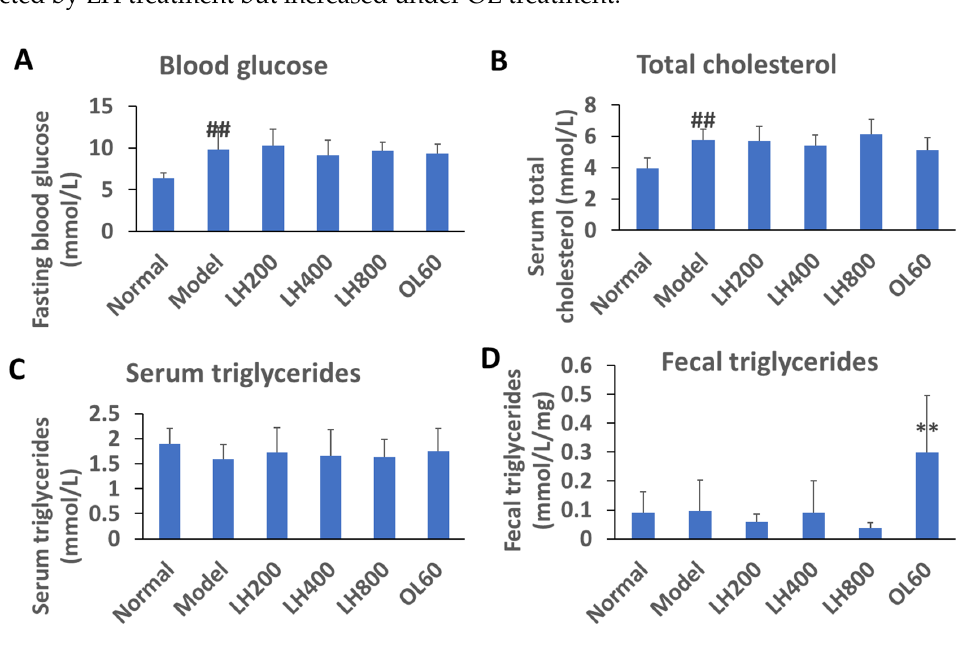
Figure 2. Effects of LH on ( A ) blood glucose, ( B, C ) lipid, and ( D ) fecal triglyceride (TG) levels of mice. Data are presented as mean ±SD, ## P < 0.01 vs normal group; ** P < 0.01 vs high-fat control group, n = 10. Normal, normal group; model, high-fat control group. LH200, LH400, and LH800: groups orally treated with LH at dosages of 200, 400, and 800 mg/kg/day, respectively; OL60: group orally treated with OL at 60 mg/kg/day.